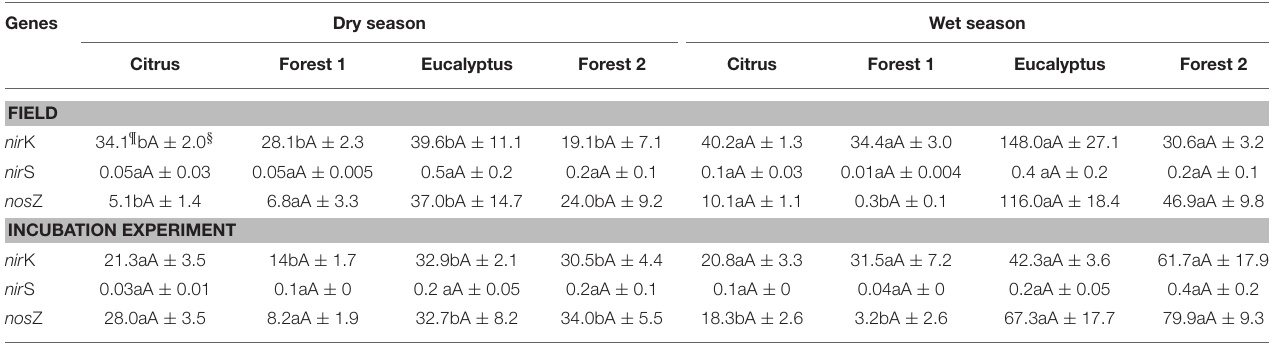
TABLE 4 | Absolute abundance of nir K, nir S, and nos Z genes measured by quantitative real-time PCR from field and incubation experiment soil samples in dry and wet seasons.